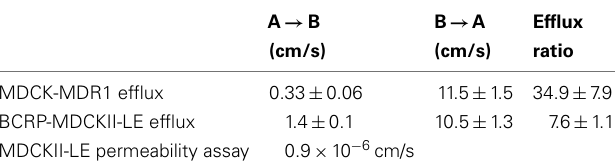
Table 1 | PF-3758309 permeability and